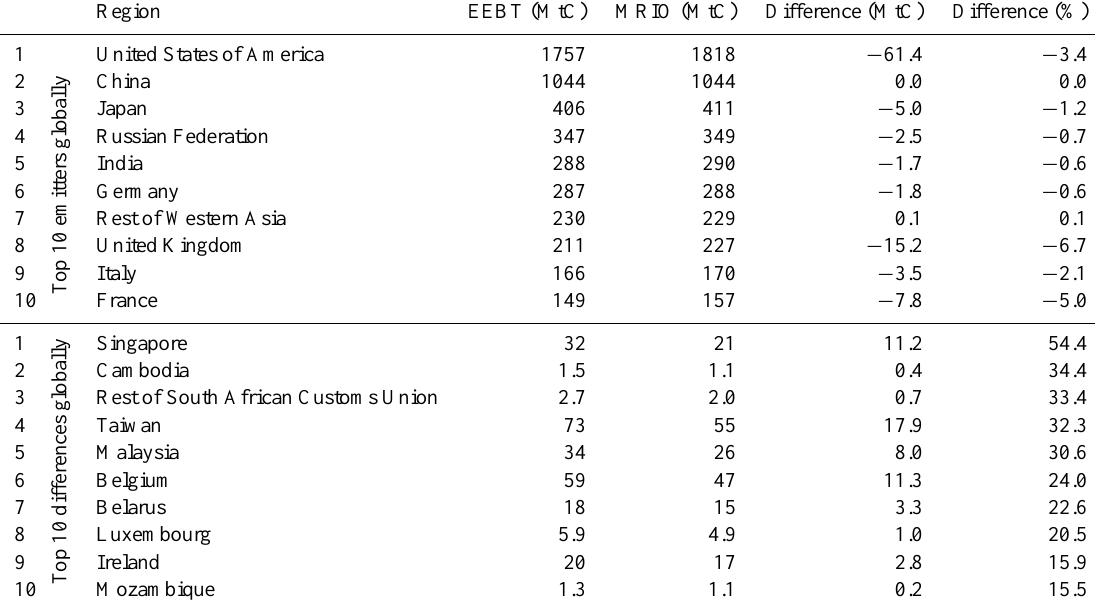
Table 6. The differences resulting from using different definitions for consumption-based inventories (2004), showing the top 10 emitters in terms of consumption and the top 10 relative differences . The differences are measured relative to the MRIO definition.